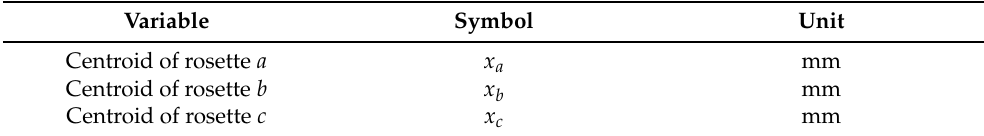
Table 1. Summary of variables to be